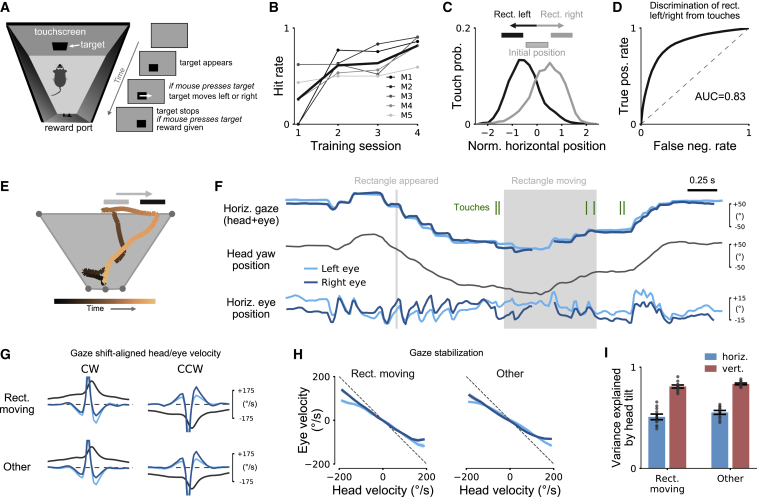
Both Types of Eye-Head Coupling Are Preserved during Visually Guided Behaviors(A) Visually guided tracking task. Mice pressed a black rectangle that appeared on an IR touchscreen. The rectangle then moved randomly for different distances to the left or right, and the mouse had to press the rectangle again once the rectangle stopped moving to get a reward at the other end of the box. Mice were first pretrained to press rectangles appearing on the screen with a single touch and then to press the rectangle for a second time after it had shifted to a new position.(B) Learning of the final version of the task in which the initial and final positions of the rectangle were non-overlapping. Data show average hit rates for 5 mice (thin lines) and average hit rate (fraction correct) across mice (thick black line). 211.1 ± 198.9 trials per session.(C) Distribution of touchscreen touches for rectangle moving left (black line) or right (gray line). Touch positions are normalized by rectangle position and width. Extent of rectangles is shown above. Data are for 4,221 trials from 5 mice.(D) Receiver operating characteristics curve for discrimination of left/right rectangle movement based on touchscreen touches for the data shown in (C). Area under curve was 0.83.(E) Example trial of mouse performing the task. Overhead view of head position with color indicating trial time as in color bar below. Gray and black rectangles show initial and final rectangle positions, respectively.(F) Gaze (top), head yaw (middle), and eye (bottom) positions for the trial in (E). Rectangle appearance and movement period are marked by gray areas. Green lines indicate time points when the mouse is touching the rectangle.(G) Eye-head coupling during gaze shifts was preserved during rectangle tracking compared to a baseline condition (“Other”; without visual stimulus). Means ± SEM (smaller than line width).(H) Relation between head and eye velocity during gaze-stabilization periods. Means ± SEM (typically smaller than line width).(I) Cross-validated explained variance (mean ± SEM) of models trained on head pitch/roll for the baseline condition (“Other”; without visual stimulus).See also Figure S4 and Videos S3 and S4.